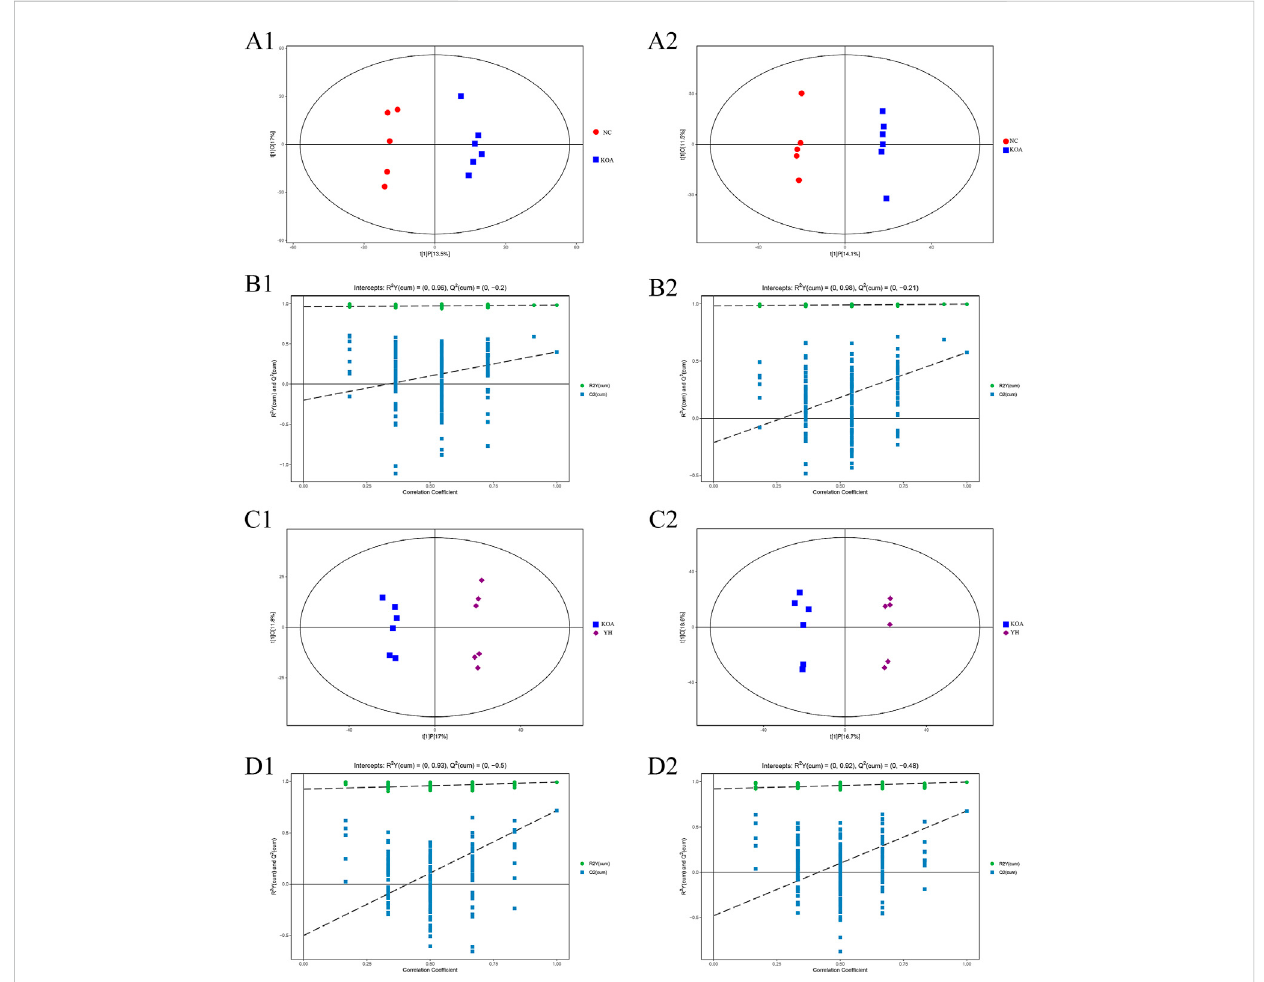
To investigate the contribution of potential biomarkers between the two groups, a volcano plot was drawn, followed by Student ’ s t-test. Volcano plot of comparison groups: KOA vs . NC (Figure 6, A1: positive ion; A2: negative ion); YH vs . KOA (Figure 6, B1: positive ion; B2: negative ion). It summarized the contribution of each variable to the model. The metabolites with VIP > 1 and p < 0.05 were considered as signi fi cantly changed metabolites. In total, 66 metabolites were identi fi ed in the heatmap of hierarchical clustering analysis between the KOA and NC groups, including 29 and 37 metabolites in the positive and negative ion modes, respectively. Between the YH and KOA groups, 81 metabolites were identi fi ed, including 57 and 24 metabolites in the positive and negative ion modes, respectively. Heatmap of comparison groups: KOA vs . NC (Figure 6, C1: positive ion, C2: negative ion); YH vs . KOA (Figure 6, D1: positive ion, D2: negative ion). Taking the intersection of differential metabolites between the KOA vs . NC group and the YH vs . KOA group, there were 16 potential biomarkers, including 8 lipids and lipid-like molecules, 2 organic acids and derivatives, 2 phenylpropanoids and